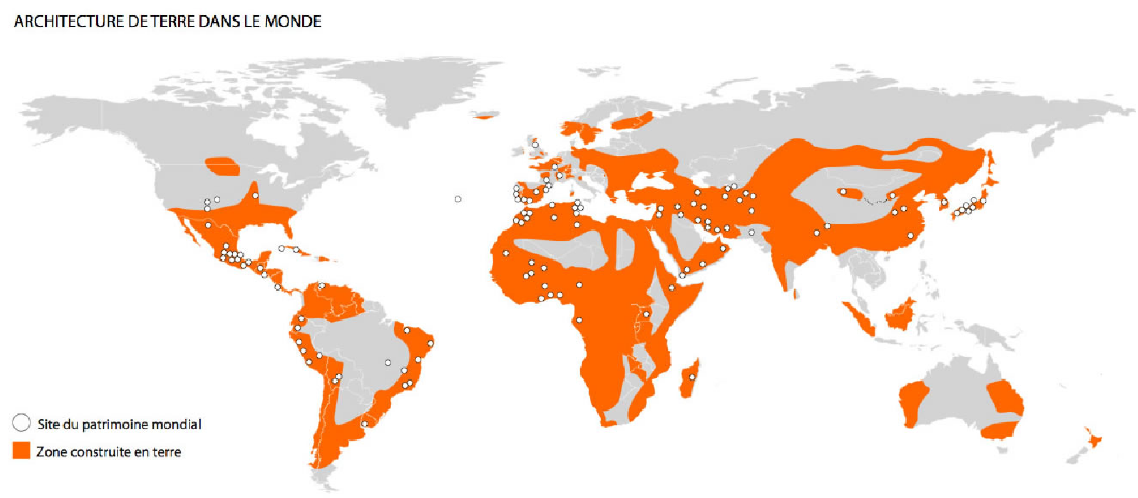
Figure 3. The orange areas are the places where unfired earth is a typical building material and white ones are stated in the UNESCO list [10].